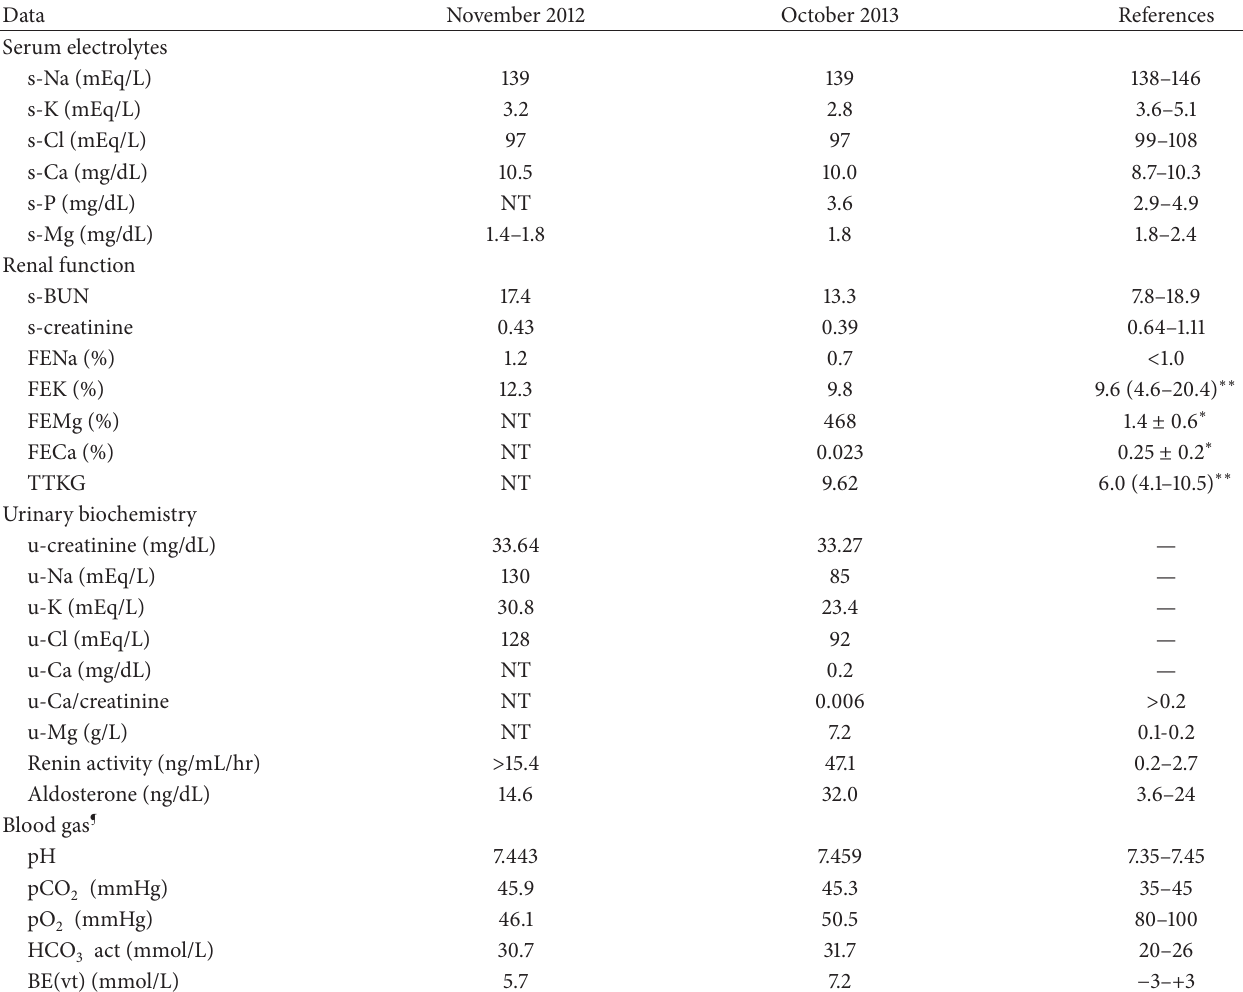
Table 1: Laboratory data obtained on two occasions one year apart.